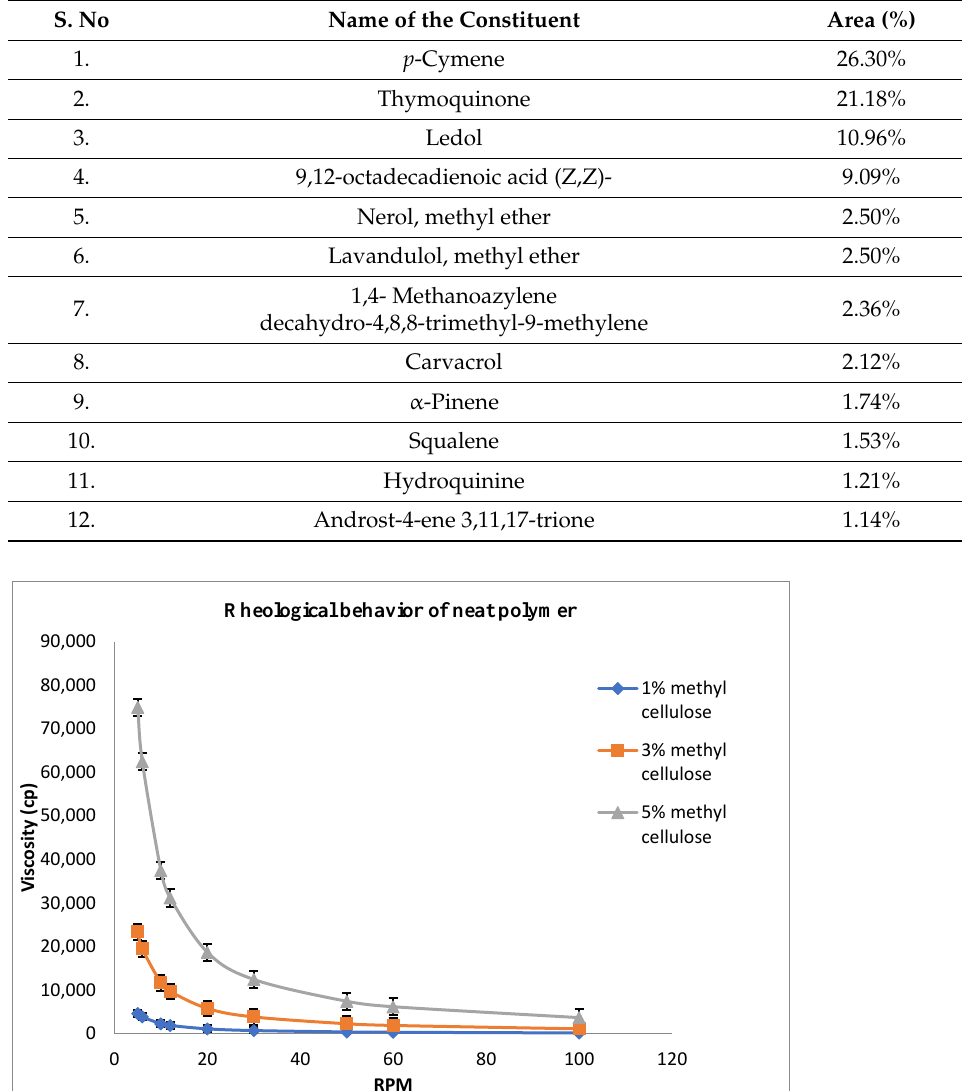
Table 3. List of major constituents identified in the NSO sample.